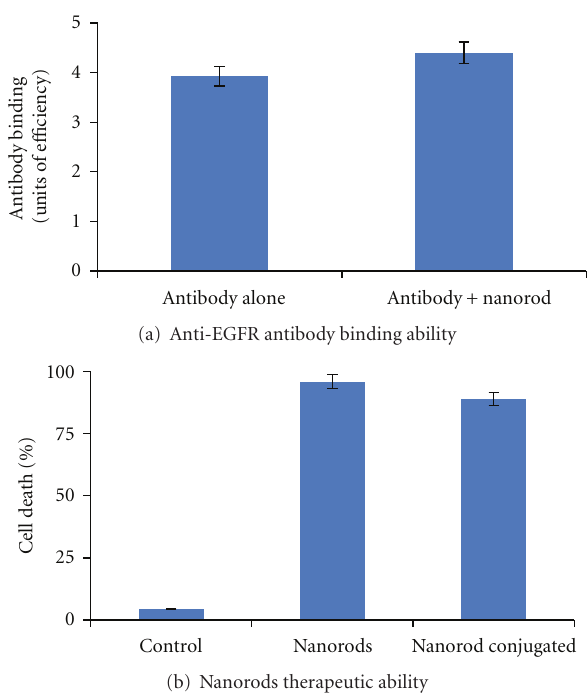
Figure 4: (a)Anti-EGFR antibody binding assay shows the antibody function before and after conjugation to the PEGylated gold nanorod. (b) Cell viability assay summarizes the percentage of cells dead after photothermal therapy with laser only, laser plus PEGylated nanorods, and laser plus nanorods conjugated to the anti-EGFR antibody.